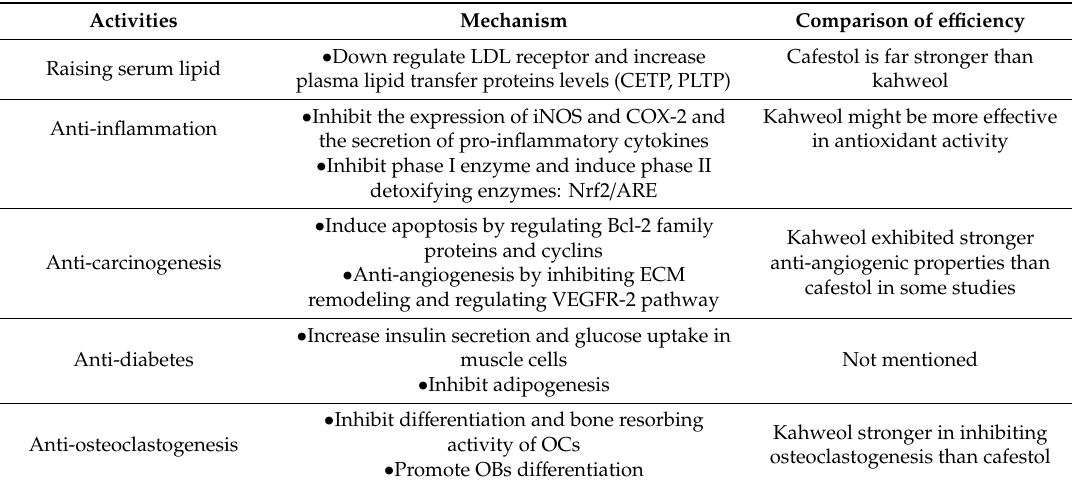
Table 1. E ff ects of cafestol and